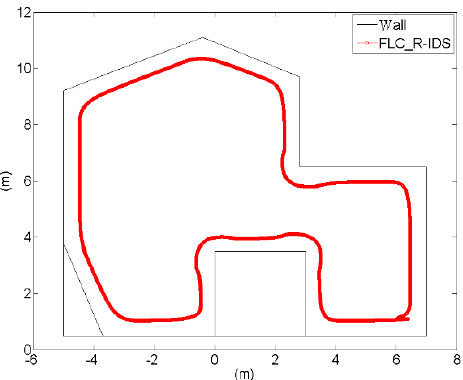
Figure 10. The path tracking of the proposed FLC_R-IDS method, following the left wall in test environment